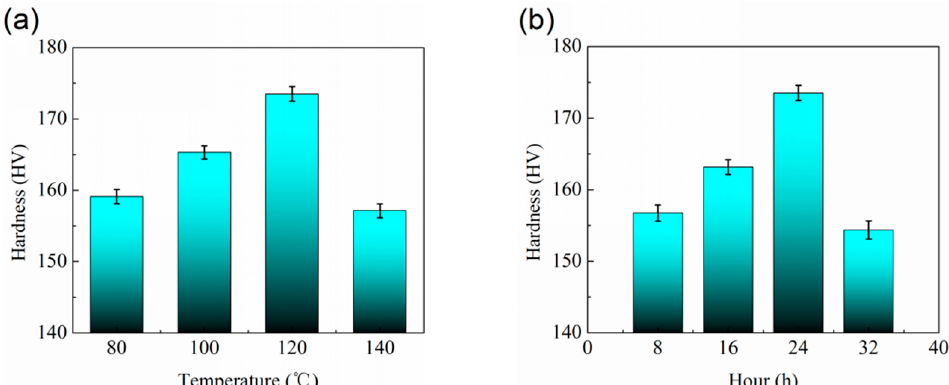
Figure 7. ( a ) Hardness of Al 2 O 3np /7075 composites aged at different temperature for 24 h; ( b ) Hardness of Al 2 O 3np /7075 composites aged at 120 °C for different time.